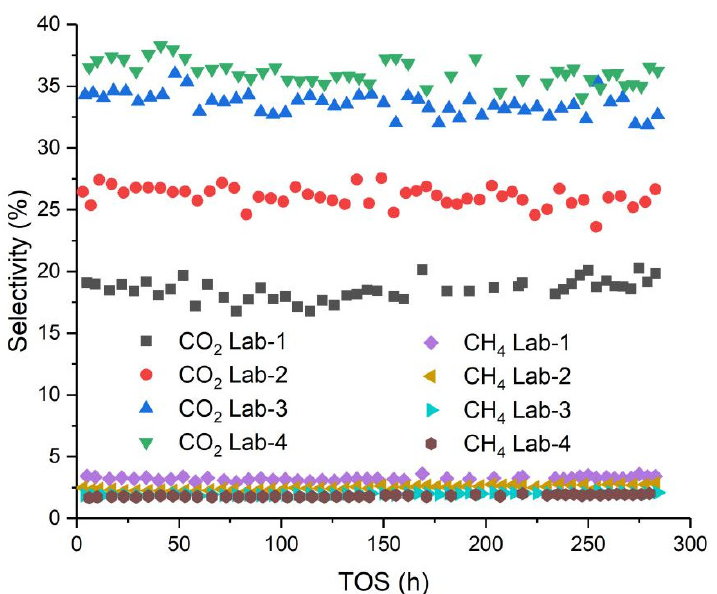
Figure 11. CO 2 and CH 4 selectivity with time on stream over the samples (reaction conditions: FBR, 2.3 MPa, 235 °C; Activation: H 2 /CO = 20, 260 °C, 24 h).